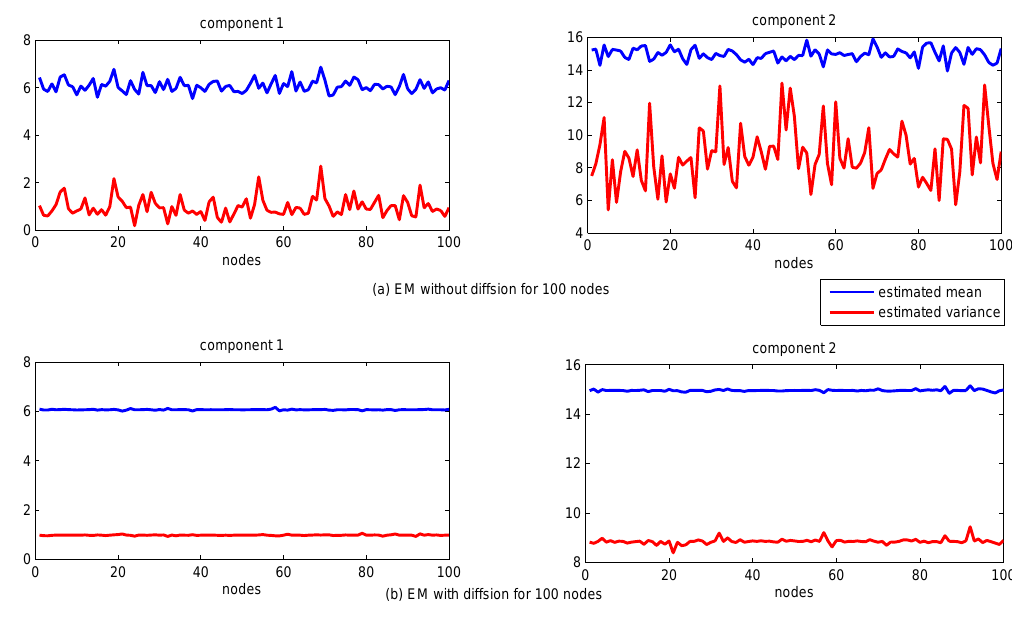
Figure 2. Estimated mean and covariance with and without